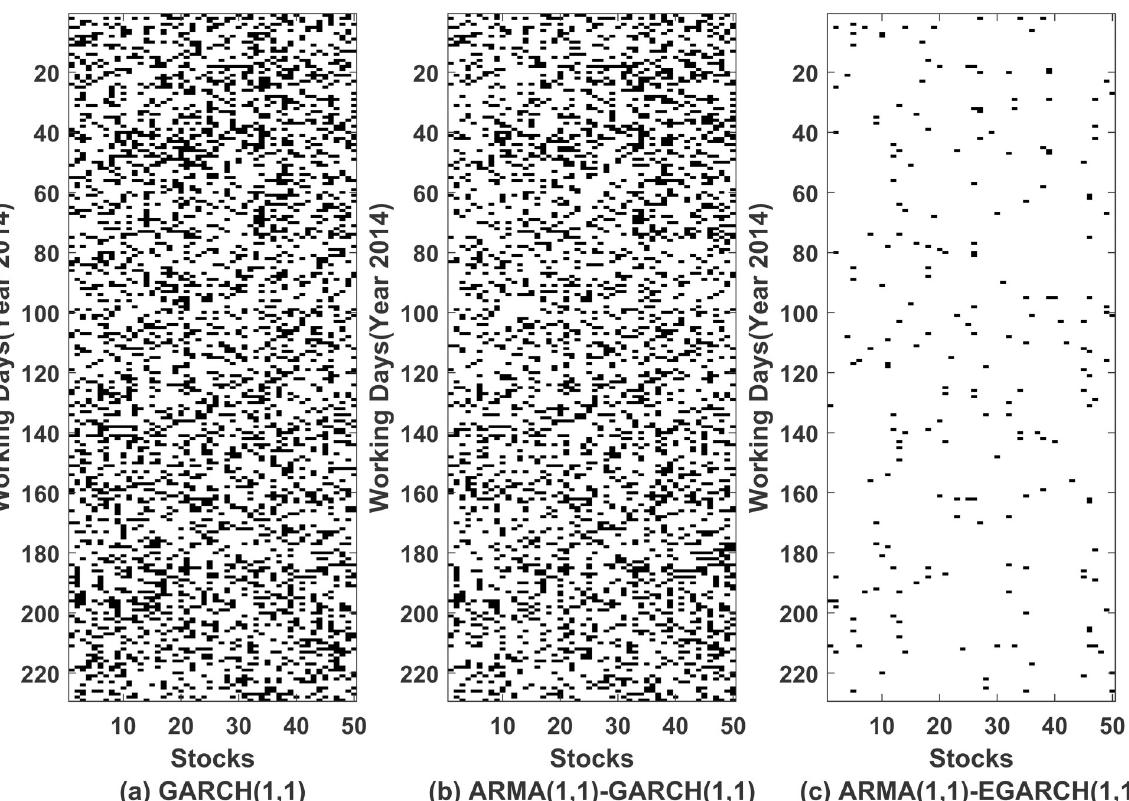
Fig 5. Ljung-Box test on squares of errors. On horizontal axis we have listed 50 stocks and on vertical axis we have working days of year 2014. Black and white colour represents that the null hypothesis ( H 0 : data is independent , H A : data exhibit serial correlation ) is rejected or accepted respectively. (a), (b) and (c) corresponds to test applied to the squares of error terms( � (1,1)-EGARCH(1,1) models respectively.